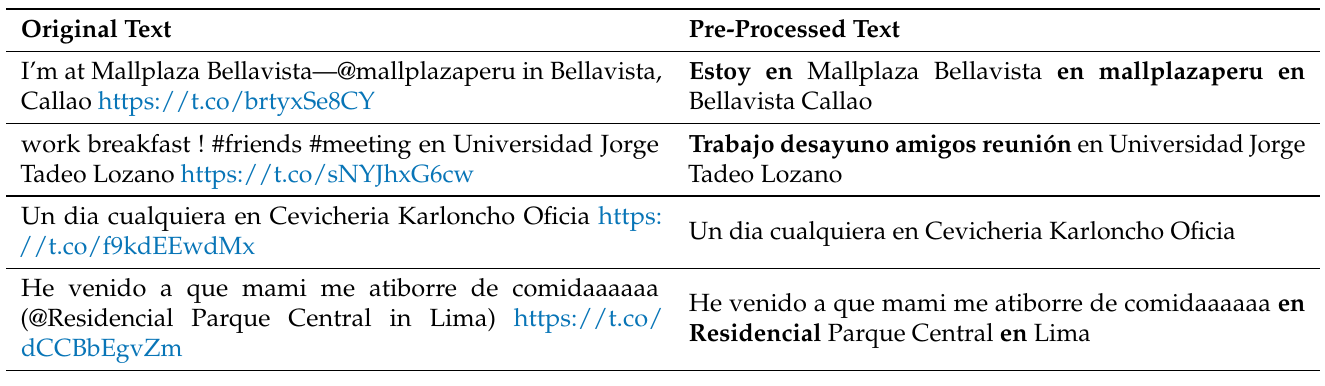
hashtags and mentions.